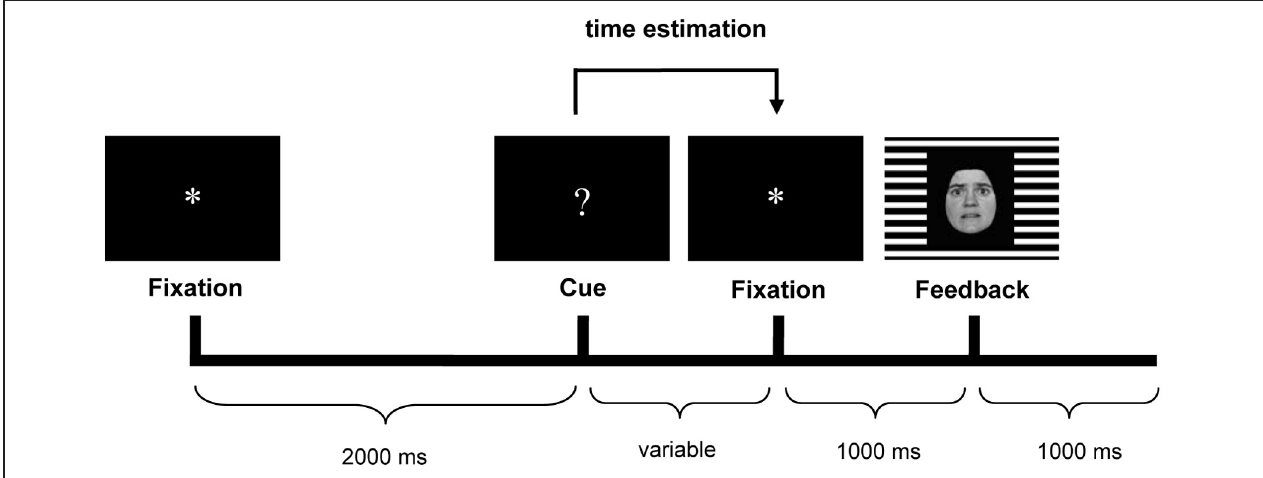
FIGURE 1 | Trial sequence with an example of the feedback stimulus. Happy facial expressions indicated positive feedback, fearful expressions indicated negative feedback. The gender (male/female) of the face indicated